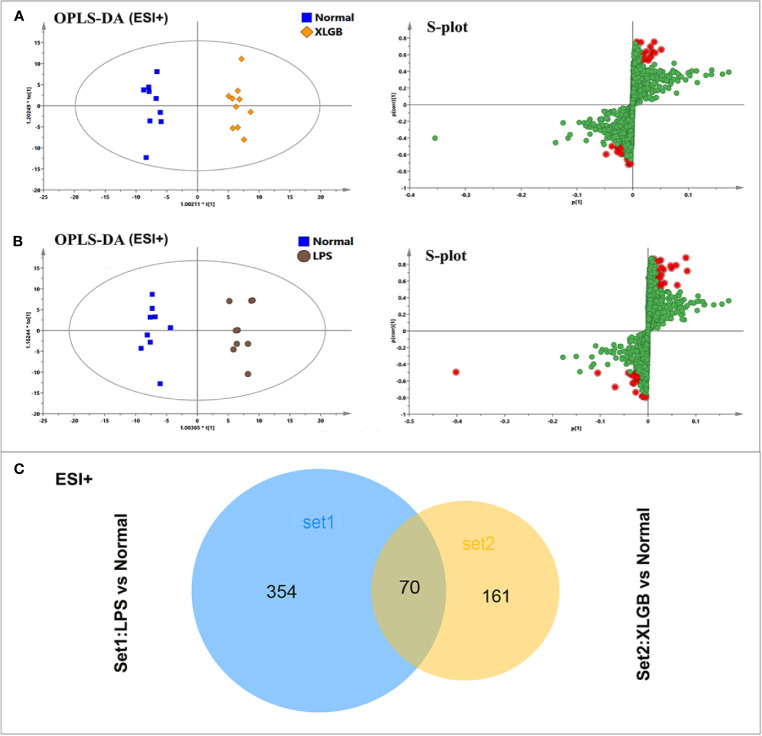
Analysis of potential biomarkers associated with susceptibility to XLGB-induced liver injury. OPLS-DA analysis of the data generated from the XLGB vs normal (A), LPS vs normal (B) in the ESI+ mode. S-score plots constructed from the supervised OPLS analysis, the axes that are plotted in the S-plot from the predictive component are p1 vs p (corr)1, representing the magnitude and reliability respectively. Metabolite ions with VIP value >1 were marked with a red square. (C) The shared and unique numbers of metabolites were also visualized in Venn diagram from LPS vs normal and XLGB vs normal.